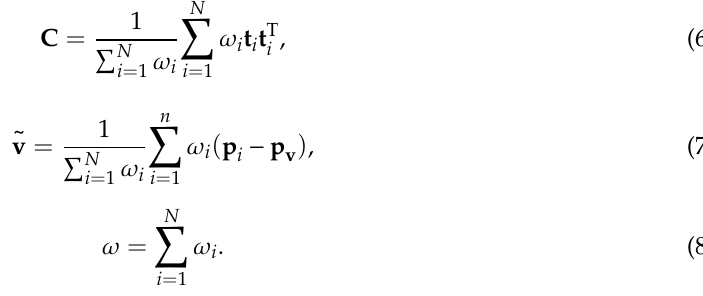
Figure 3. An example of the fundamental cell of the line segment 1 2 pp ; t 1 and t 2 are the tangents at each endpoint of the line segment; all voxels in the cell must be located between the two planes perpendicular to the two tangents and the distance from the central point p v of voxel v toward the closest point p c must be less than the cylinder’s radius (envelope size).